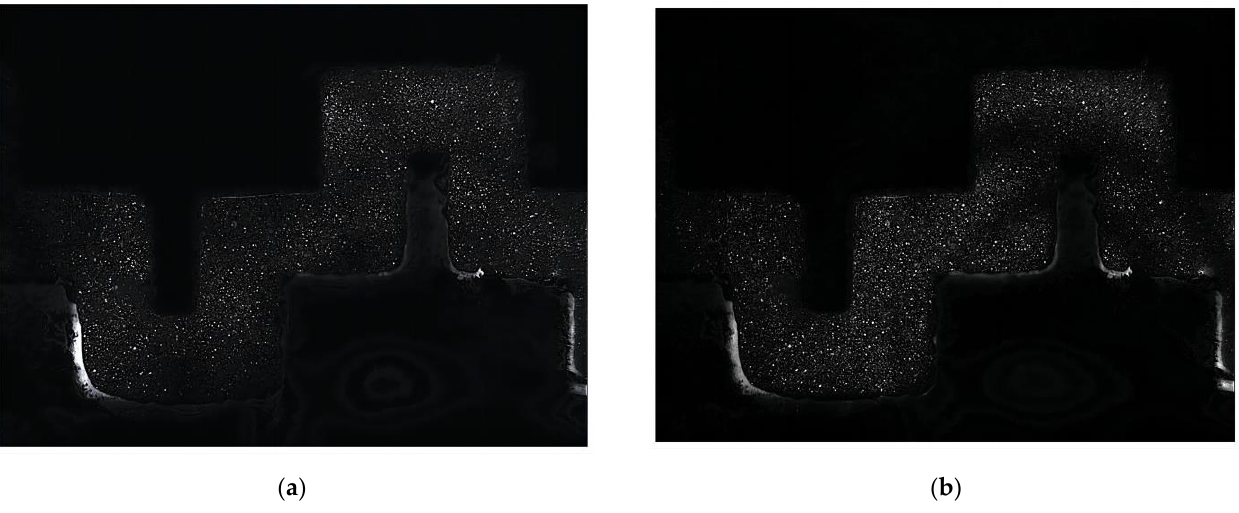
Figure 4. Particle distribution images of flow path cells at adjacent moments. ( a ) time T1; ( b ) time